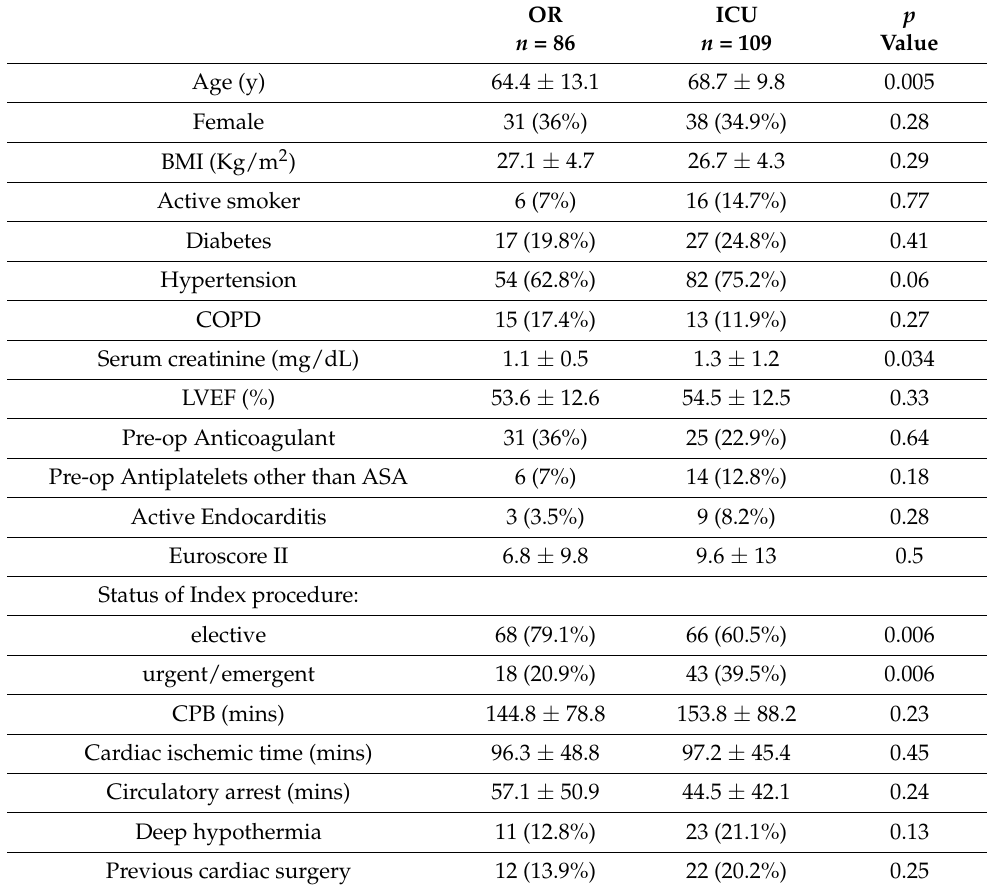
Table 1. Baseline characteristics and Intraoperative details.